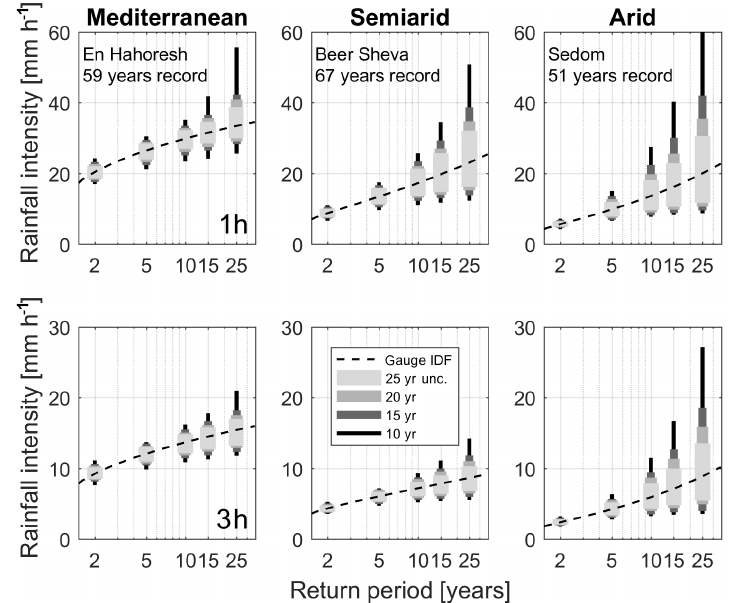
Figure 9. Uncertainty related to the record length for 1 and 3h durations for three example cases in the Mediterranean (En Hahoresh), semiarid (Beer Sheva) and arid (Sedom) climates. The dashed lines show the IDF curves from the full records (59, 67, and 51 years, respectively) and the vertical bars show the width of the 5–95th quantile interval of the 999 bootstrap sampling repetitions for record lengths of 10, 15, 20, and 25 years. Width and light of the colour of the bars increase with the record length.